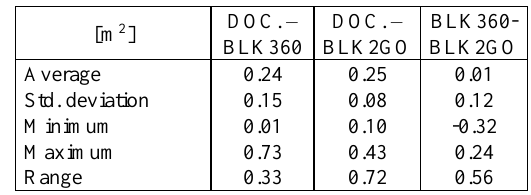
Table 3 . Comparison of areas (number of observations = 30).